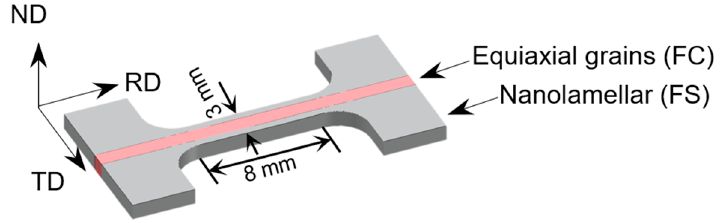
Figure 2. Schematic diagram of the tensile sample after welding is